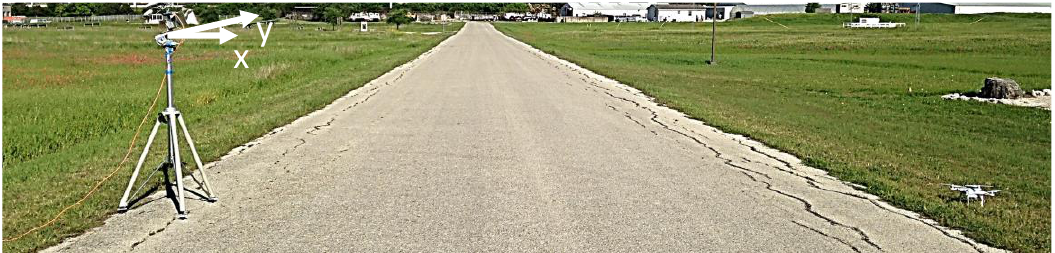
Figure 6. In-flight drone measurement setup.